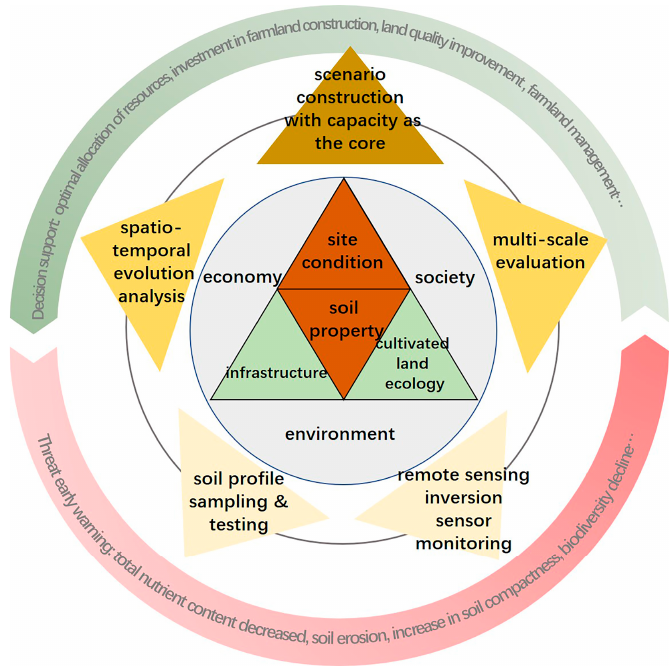
Figure 4. The cognitive framework of cultivated land quality in the black soil region. The triangle of the innermost circle represents the component of cultivated land quality. The triangle of the second circle represents different measures and methods to recognize the quality of cultivated land. From top to bottom, it represents the change of research perspective, namely: large scale of governments/authorities representative, medium scale of businesses/regions representative, small scale of farmers/farms representative. The arrow representing the outermost circle can provide decision support for cultivated land use and threat warning for cultivated land quality by analyzing cultivated land quality.